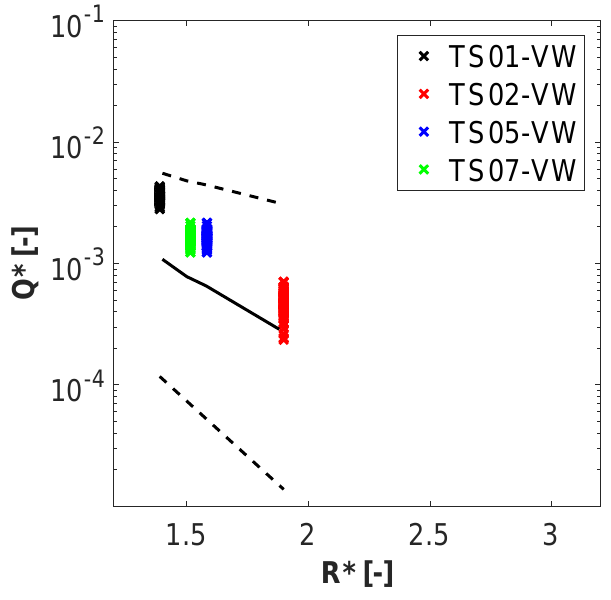
Figure 7. Graph showing R ∗ plotted against Q ∗ for random seeding test with vertical wall structure. Solid line: Empirical prediction. Dashed line: Confidence Bounds.